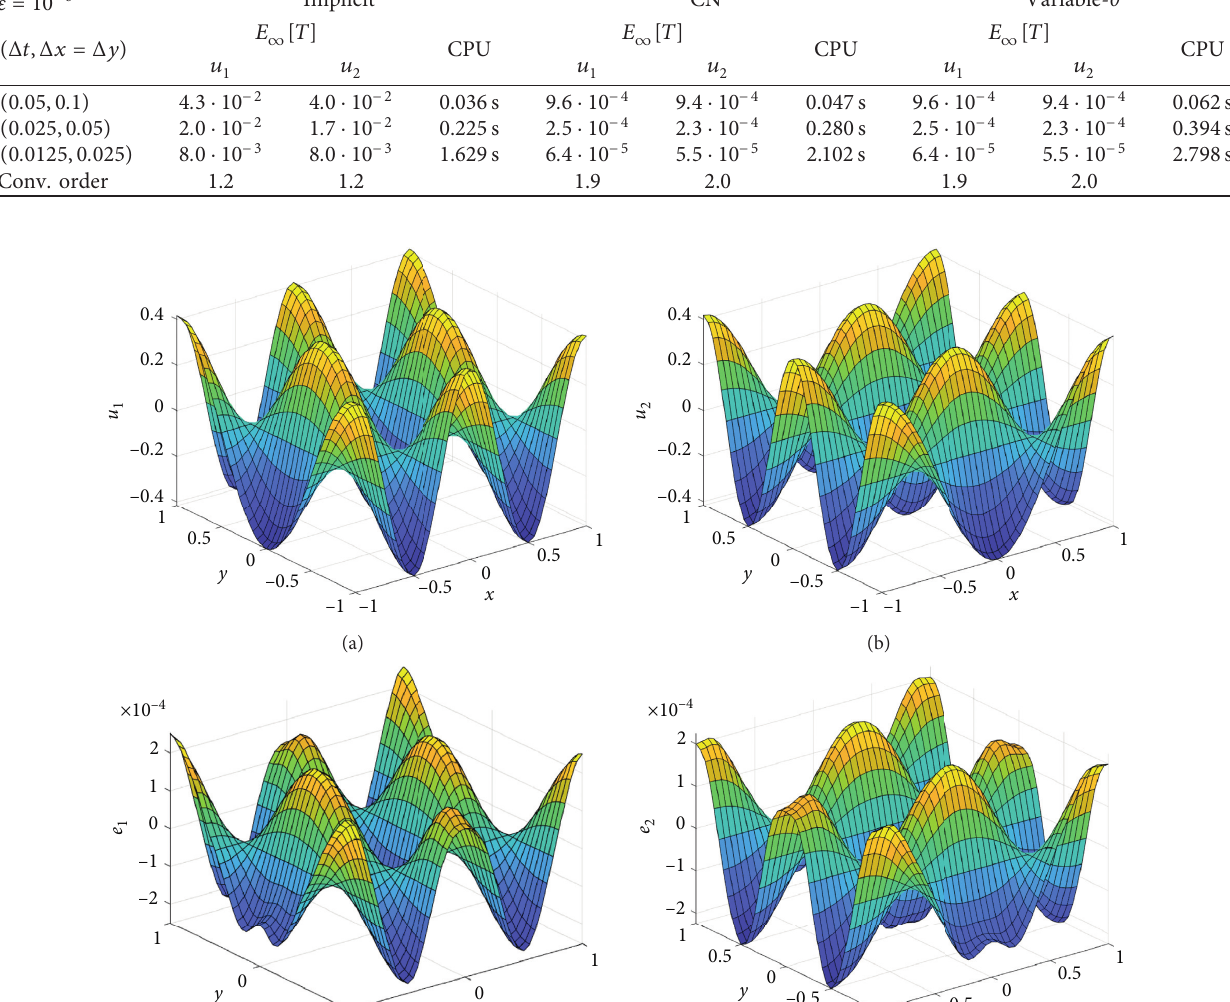
� u − 􏽢 u � u − 􏽢 u , (b) u , (c) e , and (d) e . 1 2 1 1 1 2 2 2